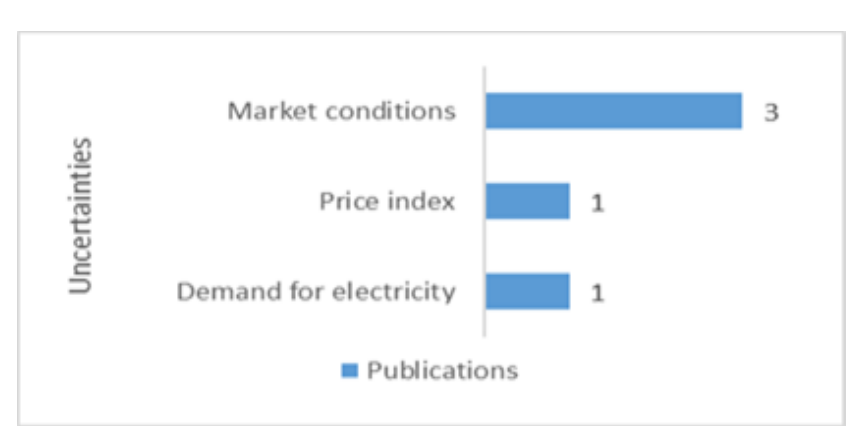
Figure 9. Market.